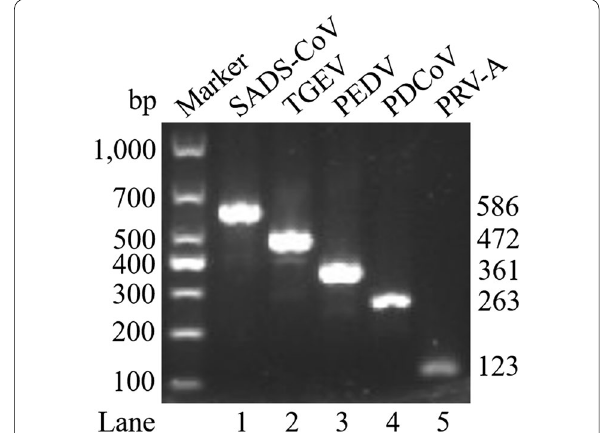
Fig. 1 Development of a single DPO RT-PCR assay for detection of SADS-CoV, TGEV, PEDV, PDCoV, and PRV-A. M, Marker; Lane 1, SADS-CoV; Lane 2, TGEV; Lane 3, PEDV; Lane 4, PDCoV; Lane 5,